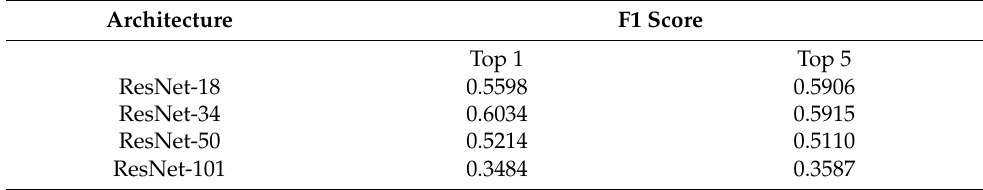
Table 2. F1 score rates on ResNet validation.